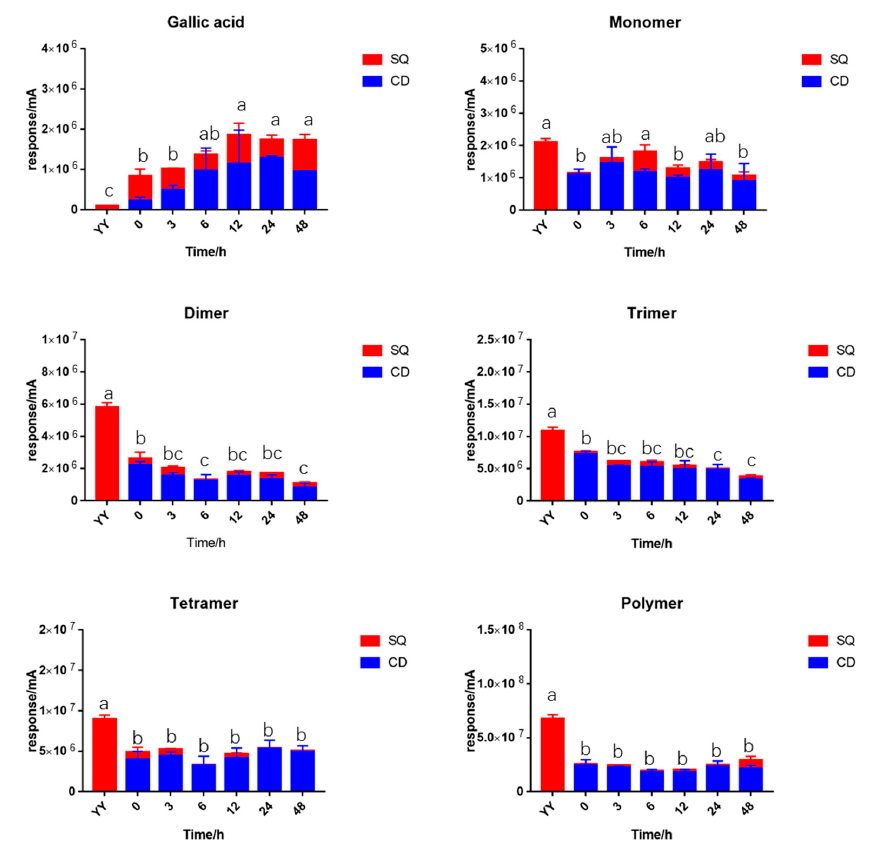
Figure 4. Changes of di ff erent degrees of polymers of BLPs (1 mg / mL) during in vitro fermentation. SQ: supernatant; CD: residual; YY; initial sample as 1 mg / mL BLPs in water. Statistical significance ( p < 0.05) is expressed by di ff erent